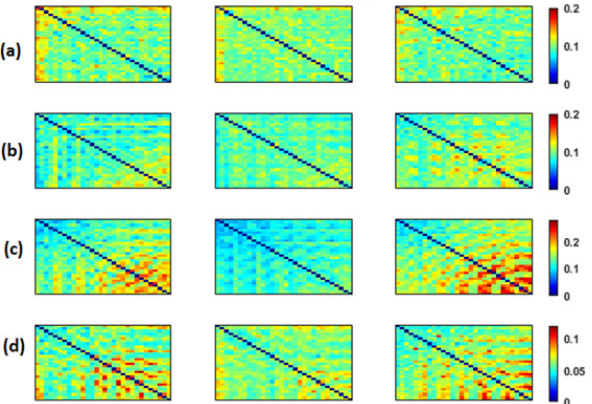
Figure 3. The average PLI across subjects in the SCI (left), MCI (middle) and AD (right) groups for the ( a ) delta, ( b ) theta, ( c ) alpha and ( d ) beta bands. The 30 electrodes are shown from left to right side, anterior-posteriorly (up to bottom). The color bar indicates the values of PLI.